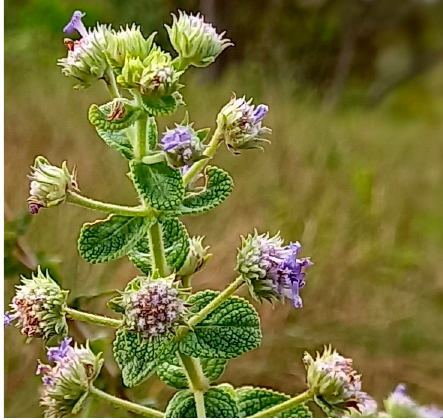
Figure 1. Hyptis crenata (Pohl) ex Benth.